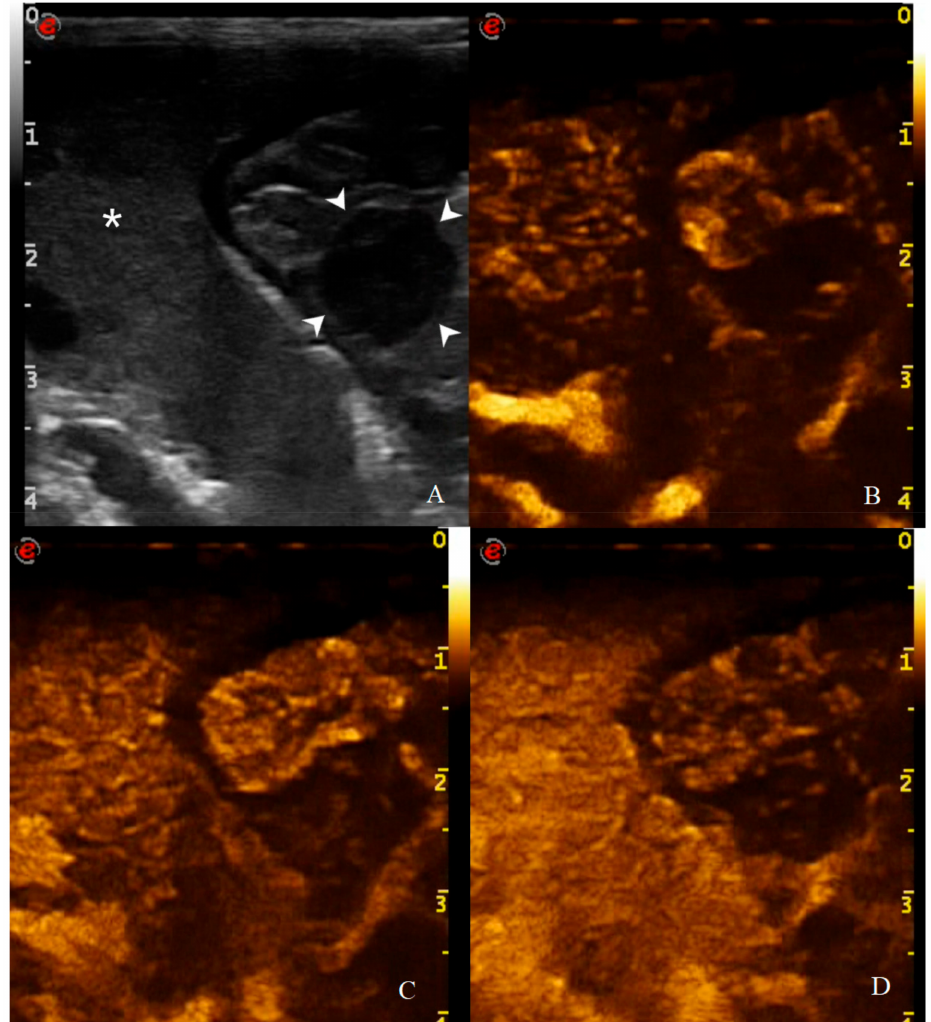
Figure 11. CEUS examination of the same dog during the peak enhancement of the time-intensity curve. CEUS enhancement pattern in a canine adenocarcinomas: ( A ) before contrast medium (CM) injection (0 s), the gastric mass (14 mm—arrowheads) and the adjacent liver parenchyma (asterisk) are visualized; ( B ) after CM injection (13 s), uptake occurs at the same moment at gastric wall and liver and the mass is classified as isoenhancing; ( C ) at peak enhancement time, contrast uptake is higher at the lesion margins and poor at its center and enhancement homogeneity is classified as heterogeneous; ( D ) in wash out phase (23 s), the enhancement decreased at gastric wall but persist in the adjacent